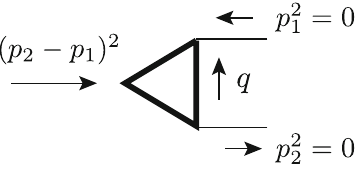
Fig. 10 Splitting regularized by μ -massive ( thick ) unobserved